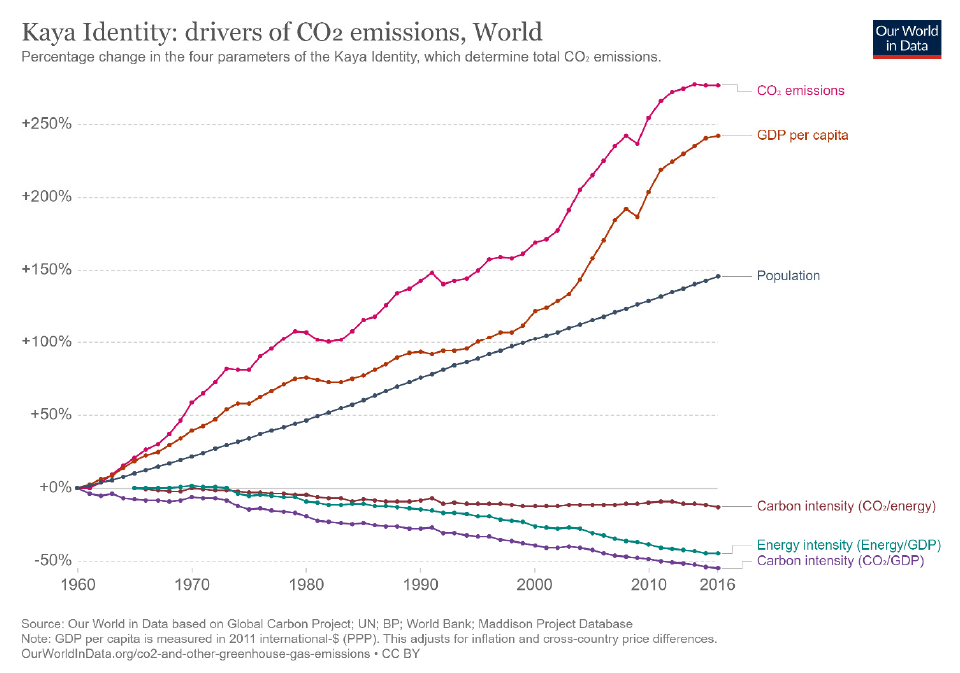
Figure 6. Kaya Identity: Drivers of CO 2 emissions, World. Source: Maddison Project Database, version 2018 [196].